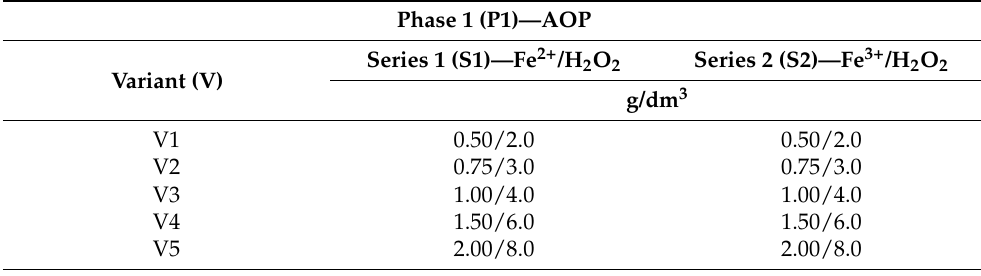
Table 1. Experimental